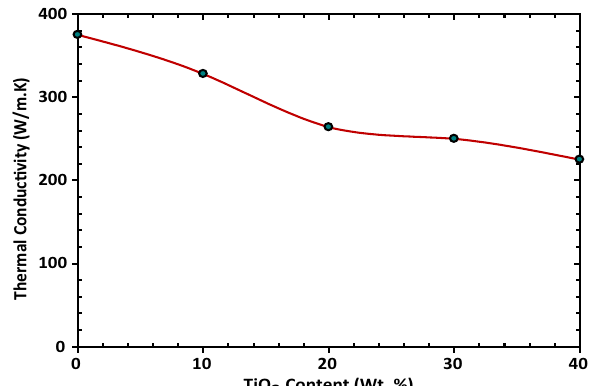
Figure 10. Representative the thermal conductivity of Cu–TiO 2 at different percentages 10, 20, 30, and 40 wt.% of